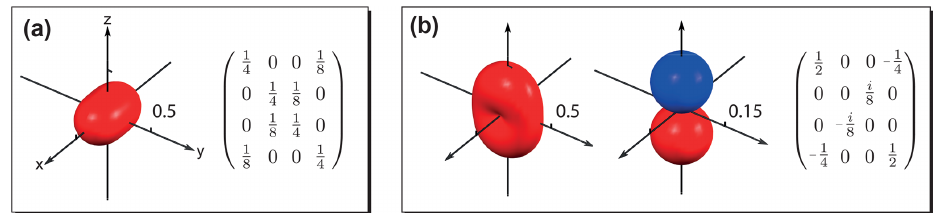
Figure 4. Examples illustrating the relationship between the symmetry of the visualized surface and the elements of the density operator. (a) Density operator written in Zeeman basis plotted with ( | 1 , 1 (cid:105)(cid:104) 1 , 1 | ) ˆ n ; (b) density operator written in Zeeman basis plotted with (left) (cid:16) (cid:17) (1 , 0) ( | 1 , 1 (cid:105)(cid:104) 1 , 1 | ) ˆ n and (right) . In panel (a) the surface is 2-fold symmetric around ˆ z , and the corresponding density operator only has (cid:99) ZQ π , 0 ˆ n 2 coherences with | (cid:49)m | = 0 and | (cid:49)m | = 2. In panel (b) , from left to right, the two surfaces are 2-fold symmetric and rotational symmetric ( q -fold symmetric for an arbitrary positive integer q ) around ˆ z , and the related density operator (written in Zeeman basis) only has coherences with | (cid:49)m | = 0 and | (cid:49)m | = 2.